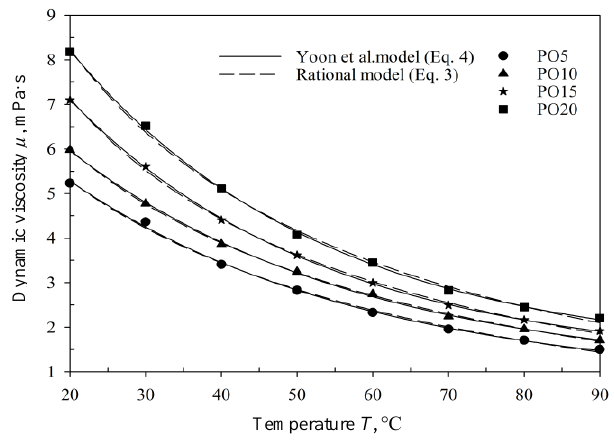
Fig. 2. Changes of dynamic viscosities of PO5–PO20 with respect to